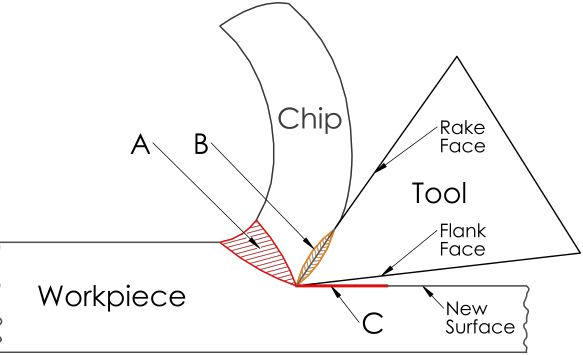
Figure 1. Sources of heat generation during metal